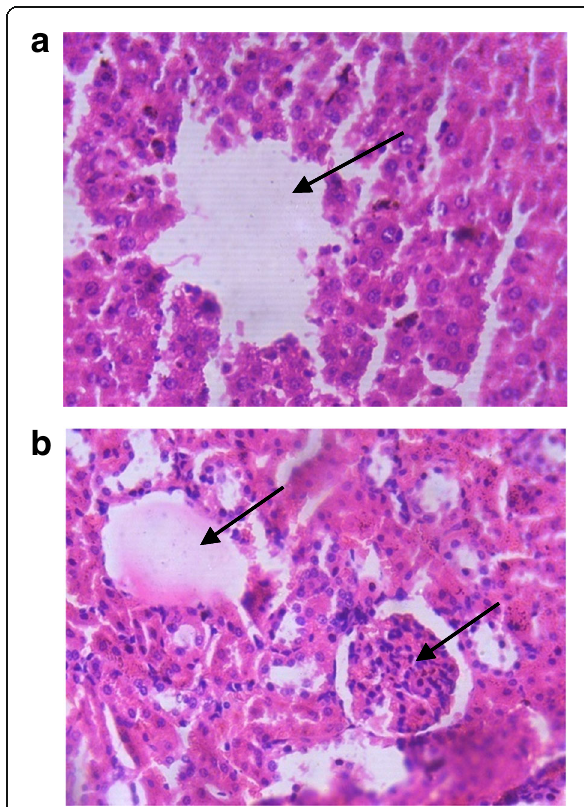
Fig. 4 a Photomicrograph of the liver section of the rats dosed with C. occidentalis showing fatty metamorphosis (× 40). b Photomicrograph of the liver section of the rats dosed with C. occidentalis showing inflammation, lymphocytic infiltration, and pyknotic-looking hepatocyte nuclei (×